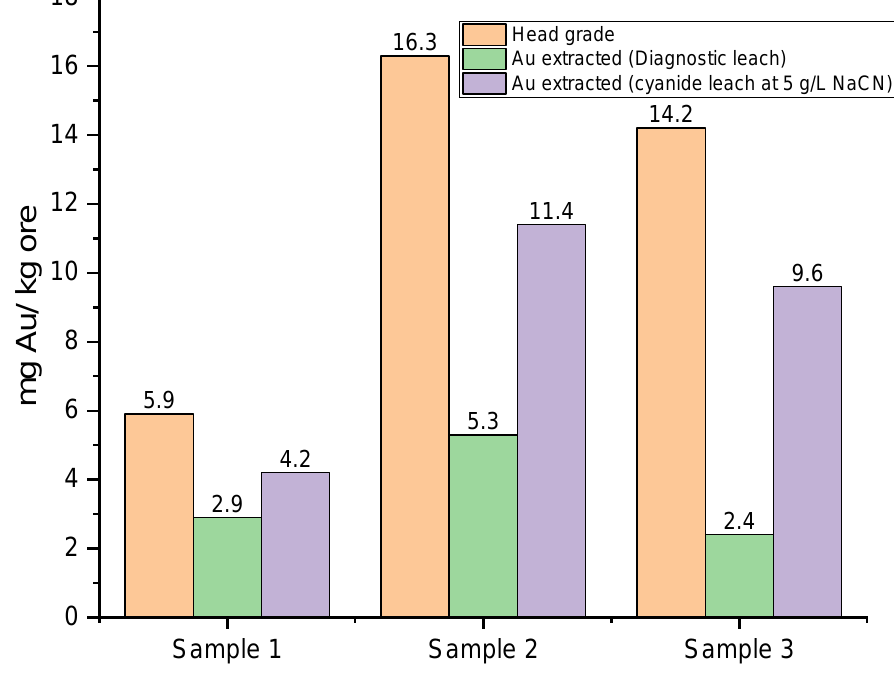
Figure 10. Comparison of total Au extracted by diagnostic leach and cyanide